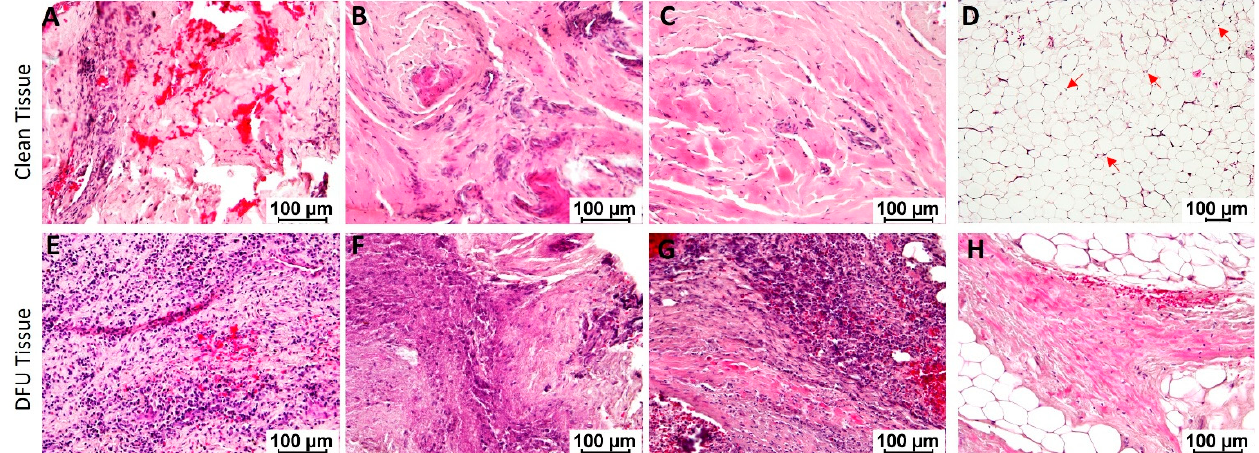
Figure 2. Hematoxylin and eosin staining in clean and diabetic foot ulcer (DFU) tissues. Clean tissues ( A – D ) and DFU tissues ( E – H ). The red arrows show the presence of a nucleus in adipocytes while most of the adipocytes in DFU tissues were without a nucleus. The images are representative images for both clean and DFU samples.